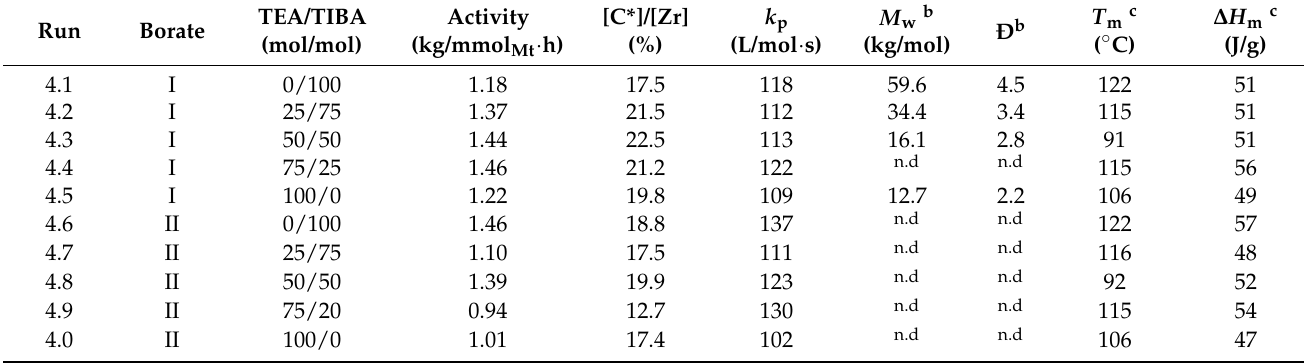
Table 4. Results of propylene polymerization Mt-II/borate/alkylaluminum a